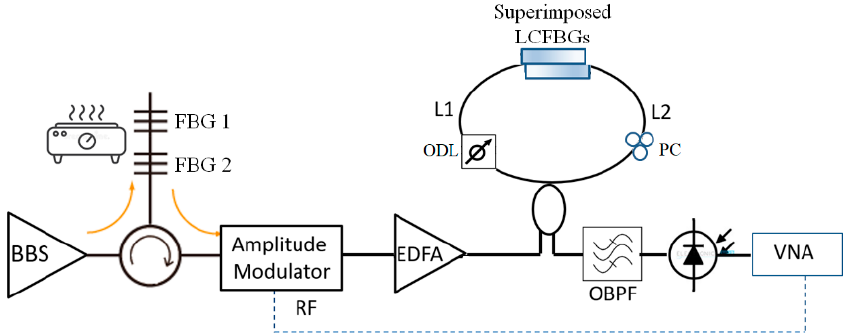
Figure 9. Experimental setup for implementing multiple two tap MWP filters based on superimposed LCFBGs in a Sagnac loop.